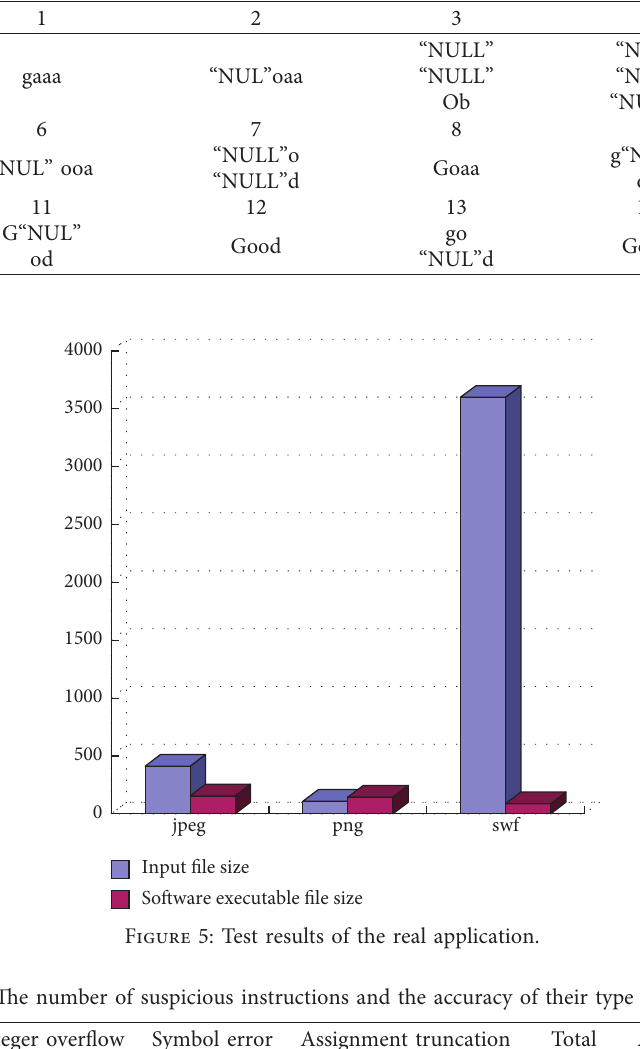
Table 1: Test results.